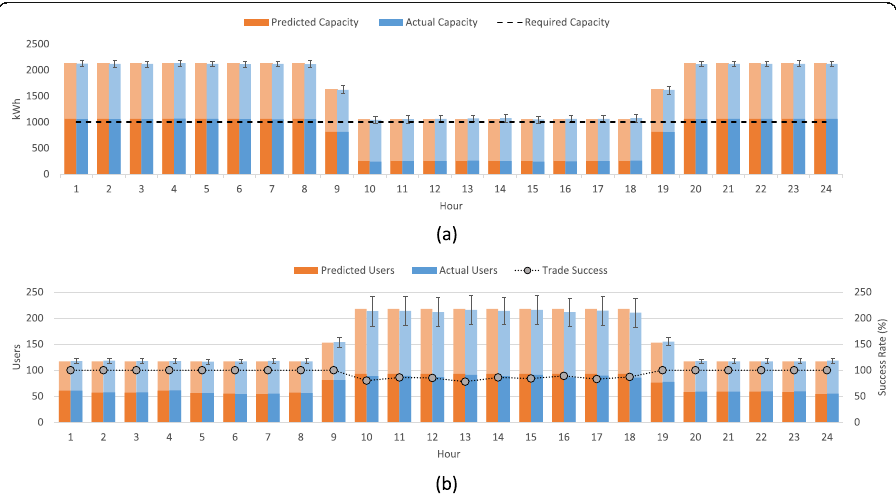
Fig. 5 Predicted vs actual capacity from all users ( a ), predicted vs actual users required for the trade and proportion of successful trades ( b ) averaged over 100 trades for each hour of a weekday. Dark column areas show contribution of type A users and light column areas type B users. Error bars show +/ − 1 standard